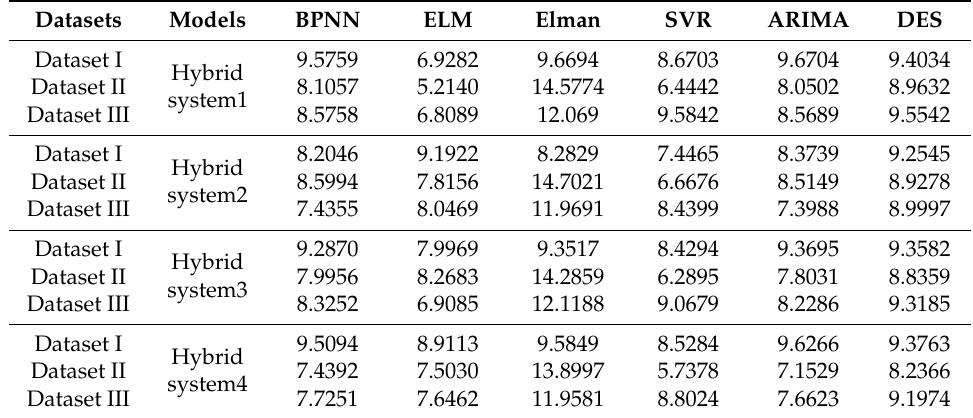
Table 11. DM test results of different models for the three datasets.